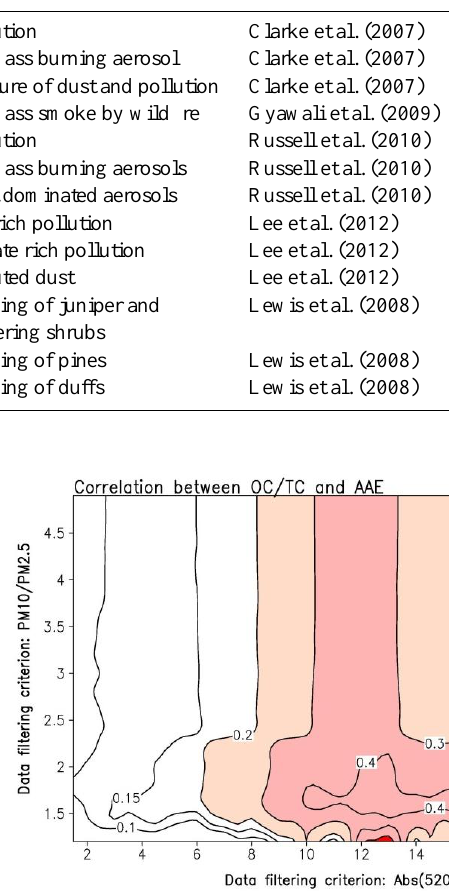
Fig. 7. Correlation between OC/TC and AAE. TC refers to total Figure 7. Correlation between OC/TC and AAE. TC refers to total carbon (i.e., EC+OC). carbon (i.e. EC+OC). OC/TC refers to the mass ratio of OC to OC/TC refers to the mass ratio of OC to TC. Correlation is calculated in the following: Mean TC. Correlation is calculated in the following: Mean OC/TC and mean AAE are computed with mean OC, mean TC and mean ab- OC/TC and mean AAE are computed with mean OC, mean TC and mean absorption at each sorption at each wavelength instead of the mean of OC/TC and wavelength instead of the mean of OC/TC and the mean of AAE. Data filtering criterion based the mean of AAE. Data filtering criterion based on PM 10 /PM 2 . 5 on PM10/PM2.5 is as in Fig. 5, and the data filtering criterion based on 520 nm absorption is as in Fig. 5, and the data filtering criterion based on 520nm ab- sorption means that absorption < threshold is removed. Absorption means that absorption < threshold is removed. Absorption coefficient at 520 nm is in units of coefficient at 520nm is in units of 10 − 6 m − 1 . 10 −6 m −1 . Figure 7 gives an impression that the correlation is highest when the data with PM 10 / PM 2 . 5 > 1.6 are filtered out. Ac- tually, the number of surviving data is fairly small after the data associated with PM 10 / PM 2 . 5 > 1.6 are removed. Fig- ure 8 shows that the correlation rather fluctuates than de- creases when the filtering criterion decreases from 1.6. In light of Figs. 5, 7 and 8, we delete the data associated with the ratio PM 10 / PM 2 . 5 of 1.6 or higher, in order to minimize the dust influence on